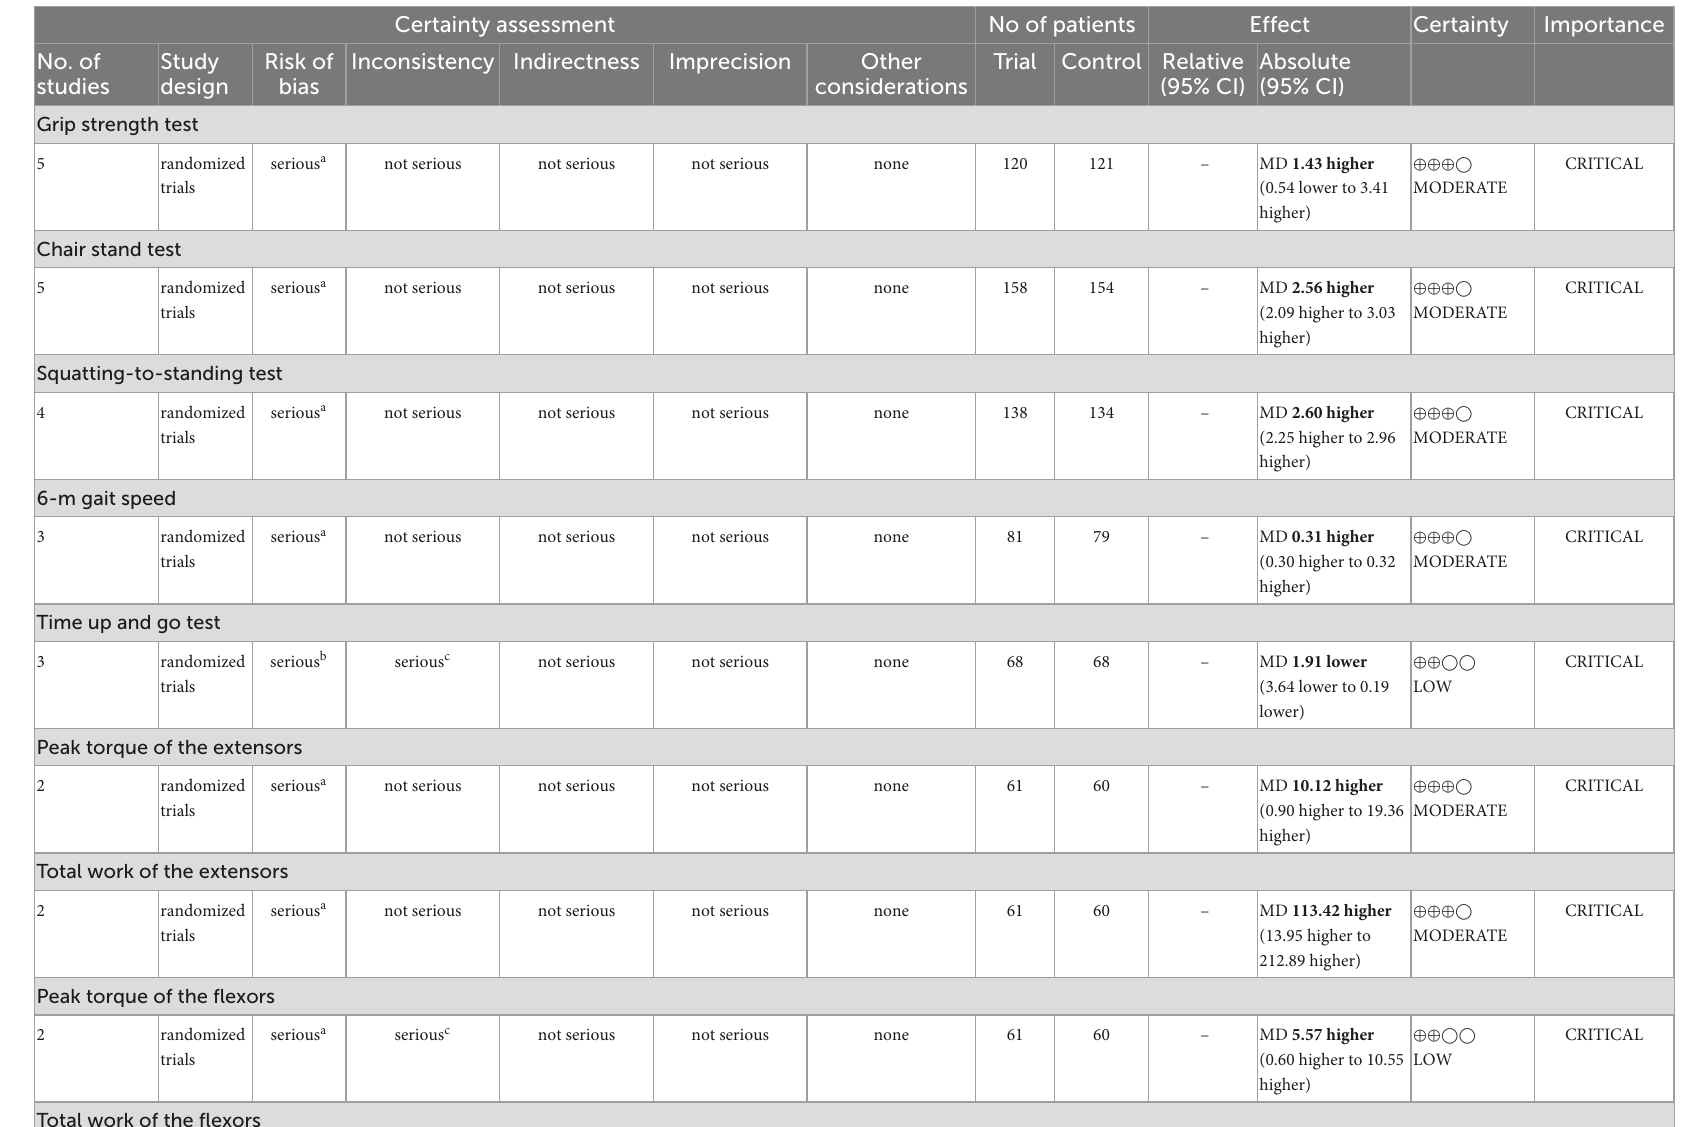
TABLE 3 Summary of GRADE on evidences of outcomes of traditional Chinese exercise (TCE) for